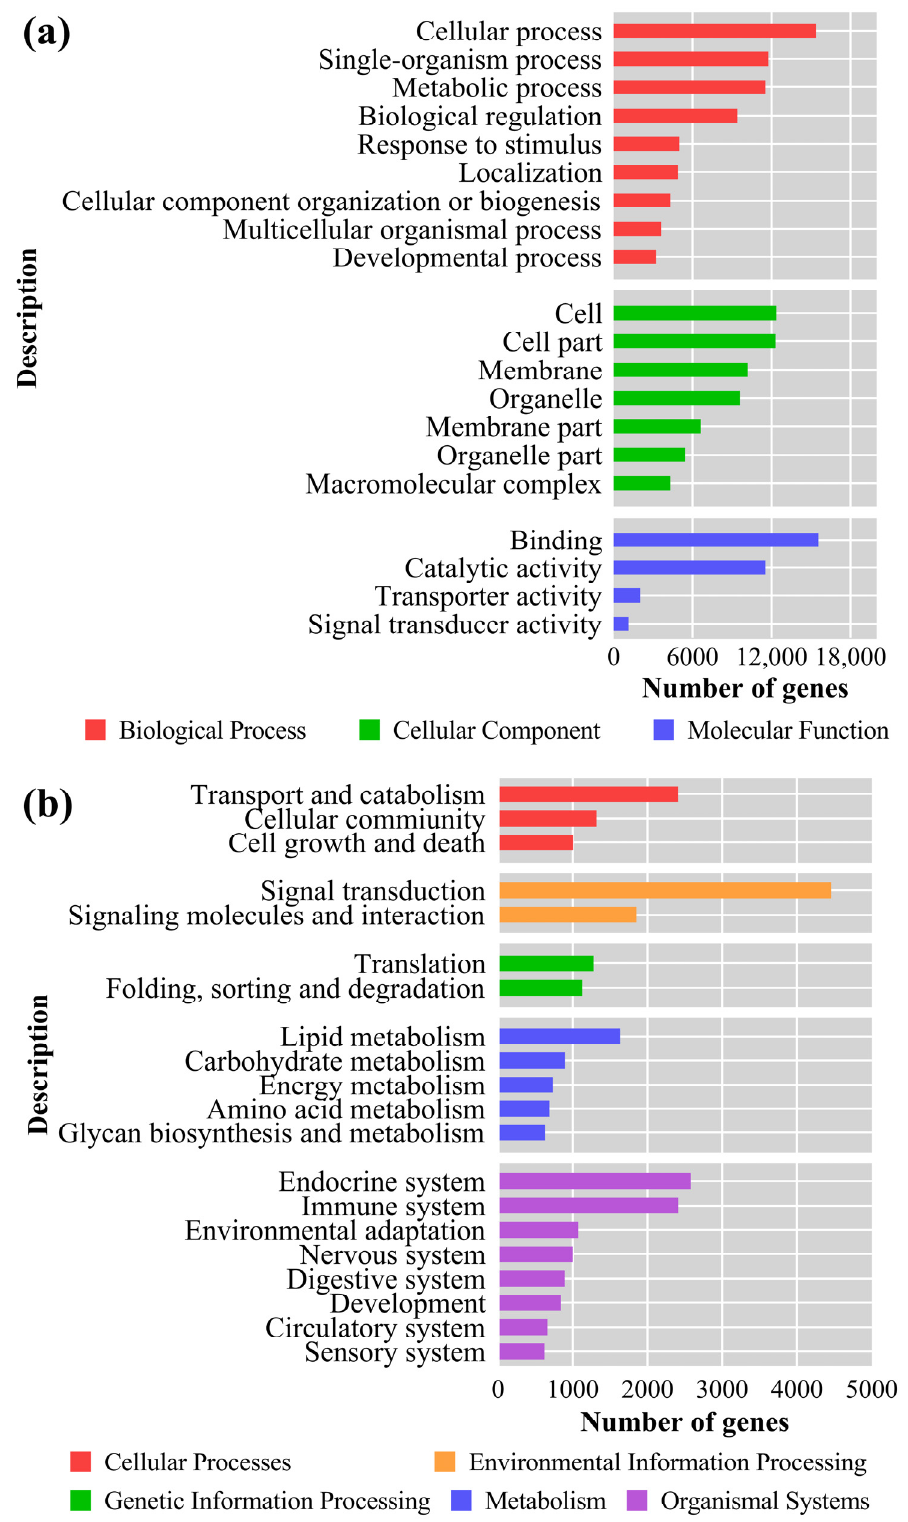
Figure 4. GO and KEGG category assignments of assembled unigenes. All unigenes were annotated into ( a ) three GO functional categories and ( b ) five KEGG categories. Table 6. The annotated eggNOG functions of unigenes.